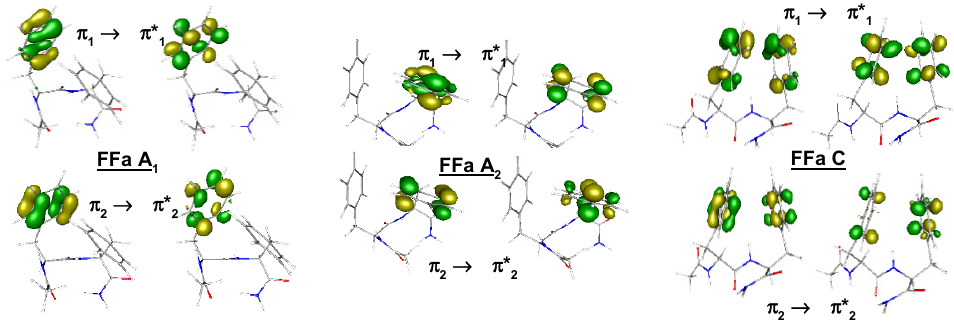
Figure 4. Couples of NTOs at the ω B97XD/cc-pVDZ level for FFa A 1 , A 2 , and C. Only couples whose contribution to the wave function is greater than 10% are drawn (see Table S9 for the values of contribution).